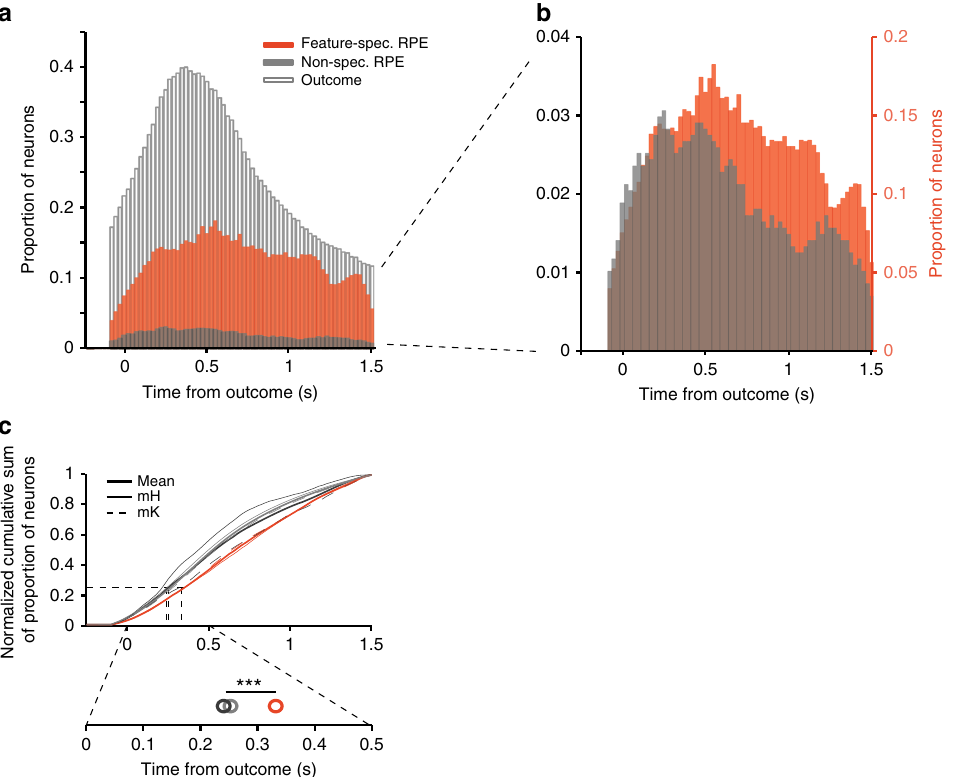
Fig. 4 Temporal pro fi le of feature-speci fi c RPE, nonspeci fi c RPE and outcome signals. a Histogram of the proportion of units encoding feature-speci fi c RPEs, nonspeci fi c RPEs and outcome in time, combined across both monkeys. For each neuron, all time bins for which an RPE/outcome was encoded are included ( n feat-spec = 774; n non-spec = 167). b Displays the same as ( a ) for nonspeci fi c and feature-speci fi c RPE encoding, but zoomed in and scaled similarly to enhance comparison of the two RPE types. c Normalized cumulative sums of the histograms in ( a ). Top: Thick lines represent the mean across both monkeys, while thin continuous lines represent cumulative sums of monkey H, and thin dotted lines represent cumulative sums of monkey K. The cumulative sum of feature-speci fi c RPEs differed signi fi cantly from those of nonspeci fi c RPEs and outcome (Kolmogorov – Smirnoff test, Bonferroni – Holm multiple-comparison correction; both p < .001). Bottom: Magni fi cation of the cumulative sums around the 25% window. Open circles represent the time points at which 25% of the respective signal is encoded. The horizontal bar with three asterisks indicates that the 25% time point of feature-speci fi c RPEs differs signi fi cantly from those of nonspeci fi c RPEs and outcome (randomization procedure, both p <